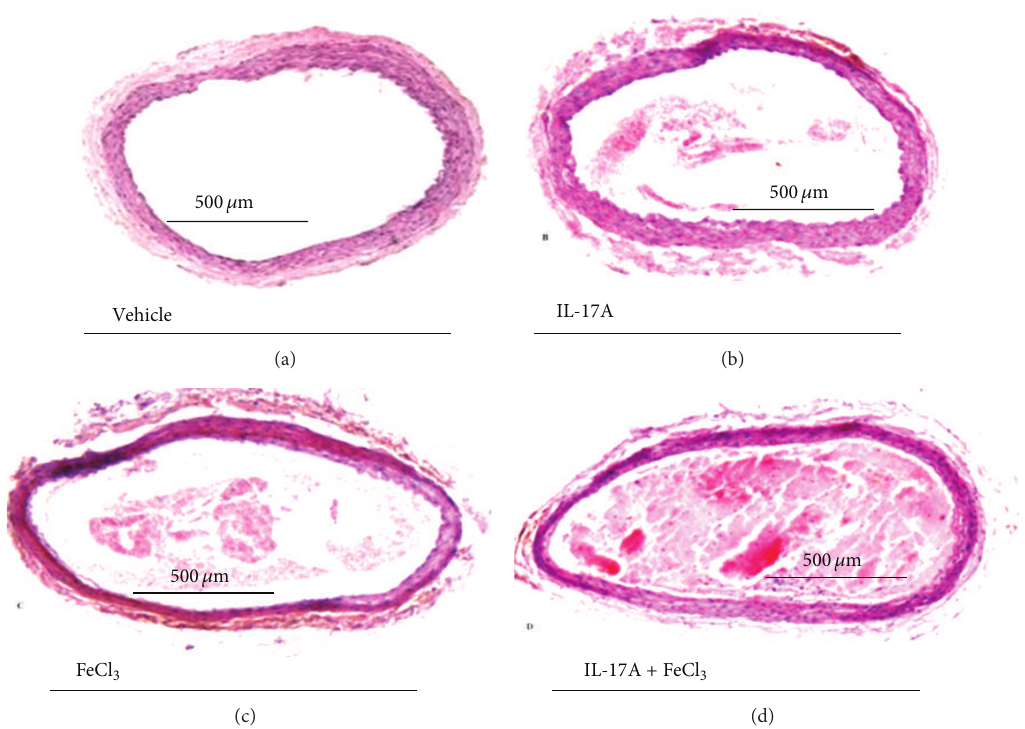
Figure 2: Photomicrographs showing hematoxylin and eosin histologic cross sections of carotid arteries following local treatment as describedinthemethodsection(magnification × 50).(a)Vehicle(HCl4 mM);(b)IL-17A(100 𝜇 g/mL);(c)vehicle(HCl4 mM) plus FeCl 3 (5%); and (d) IL-17A and FeCl 3 .